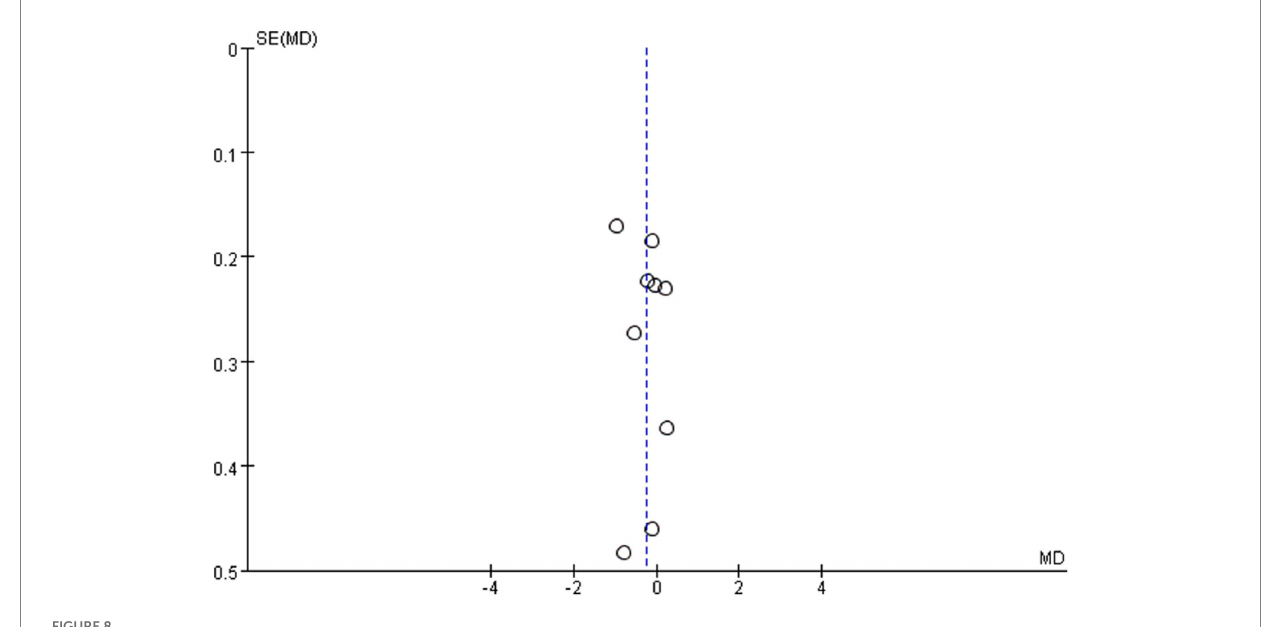
FIGURE 8 Funnel plot of publication bias